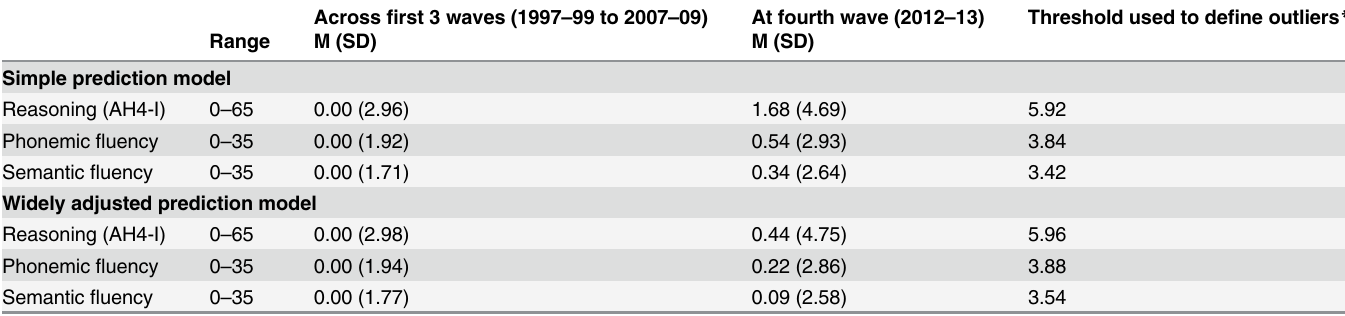
Table 2. Comparison of residuals: from 1997 – 99 to 2007 – 09 compared with 2012 – 13.